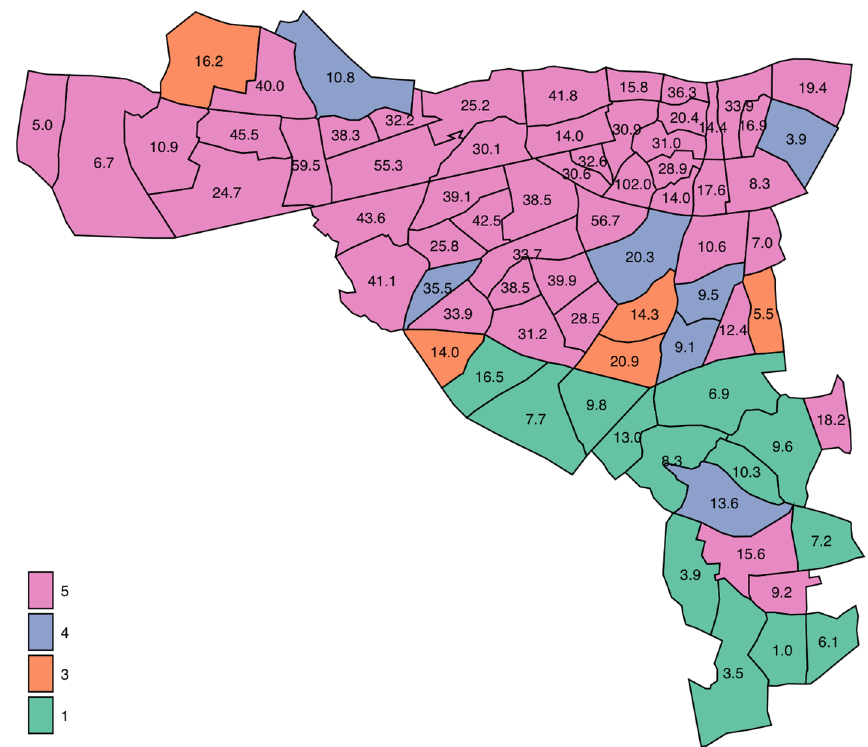
Figure 2. Spatial variation in Emergency Hospital Admission Incidence rates for medical conditions.